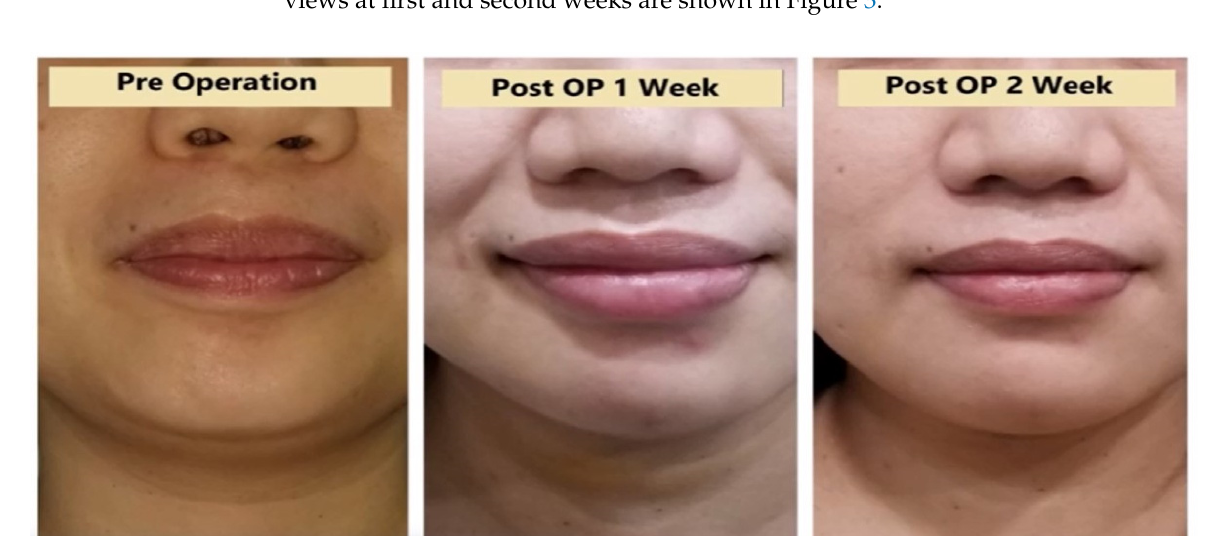
Figure 3. Profiles of a patient at the pre-operative stage and at first and second weeks following transoral endoscopic vestibular thyroidectomy. transoral endoscopic vestibular